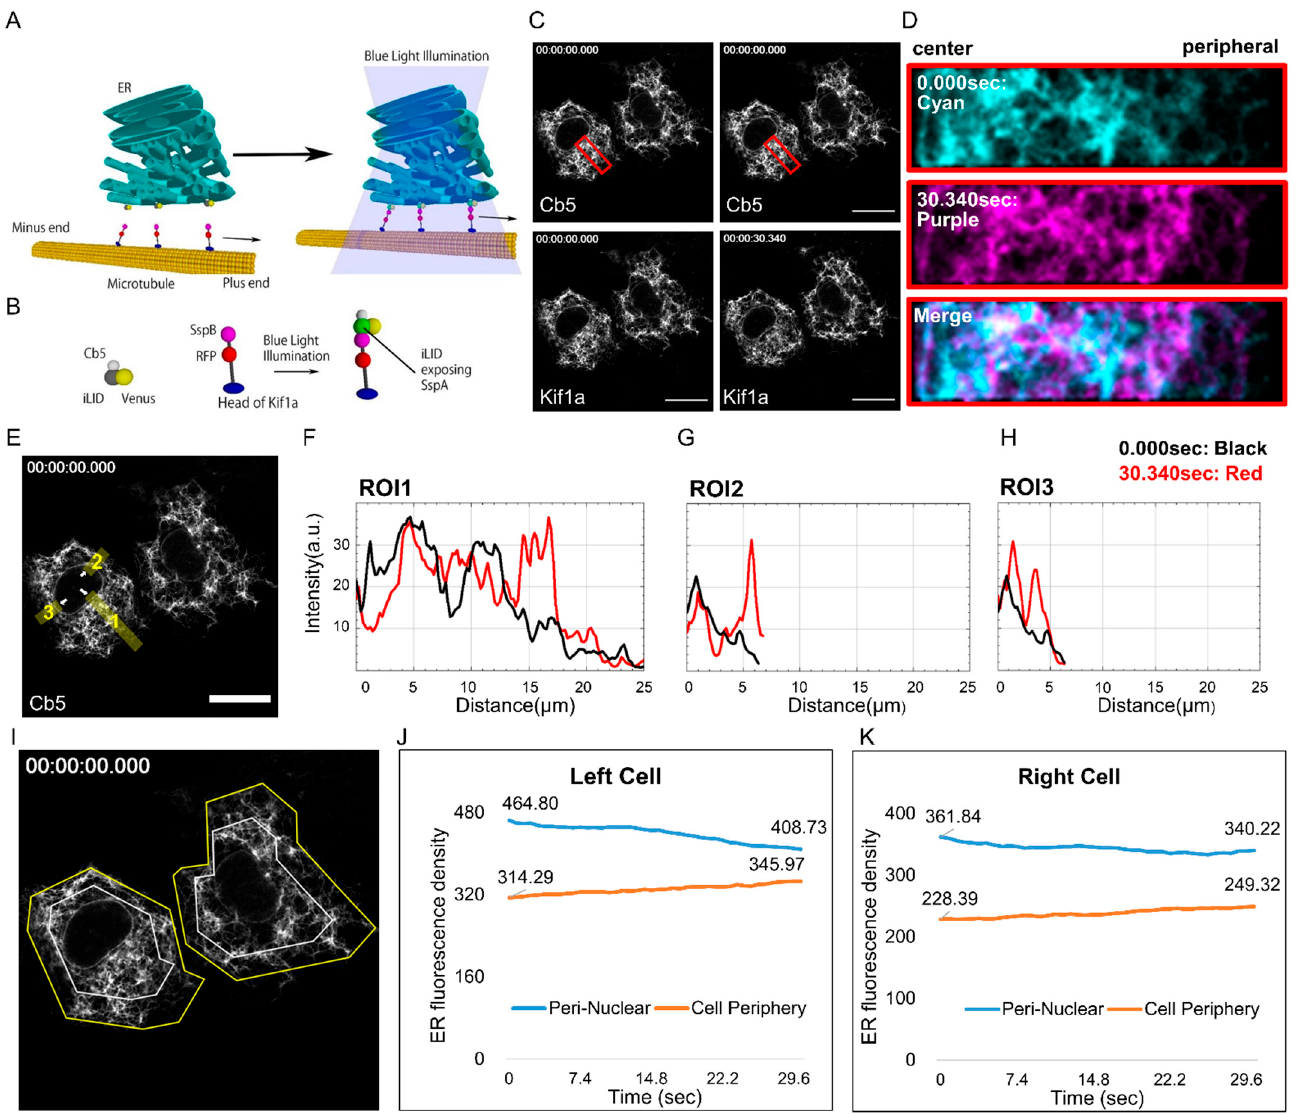
Figure 1. Design and realization of the optogenetic tool. ( A ) The illustration of the optogenetic tool. ( B ) The two plasmids designed for constituting the tool: Venus-iLID-SspB and Kif1a-tagRFP-SspB. ( C ) The time-lapse images of COS-7 cells introduced with the optogenetic tools. Fluorescence signals representing Kif1a and Cb5 are shown. The start point was defined as 0.000 s, the moment the blue light turned on. The evaluation point was set after 30.340 s illumination. ( D ) Red frames in ( C ) are aligned and zoomed for comparison by the two colors (0.000 s: Cyan, 30.340 s: Purple). ( E ) ROIs taken in Cb5 fluorescence images for plot profile analysis at different directions (white arrows: the “0” for the horizontal axis of the plot file). ( F – H ) The plot profile of ER fluorescence in ROI 1-3. The charts indicate that the endoplasmic reticulum (ER) was translocated centrifugally by the optogenetic tool. ( I ) ROIs with the same area were taken in Cb5 fluorescence images for intensity comparison (perinuclear: white frame; pericellular: the space between white and yellow frames). ( J , K ) The line graph shows the Cb5 fluorescence intensity changes in the perinuclear and pericellular area of the left and right cell. Scale bars: 25 μ m.